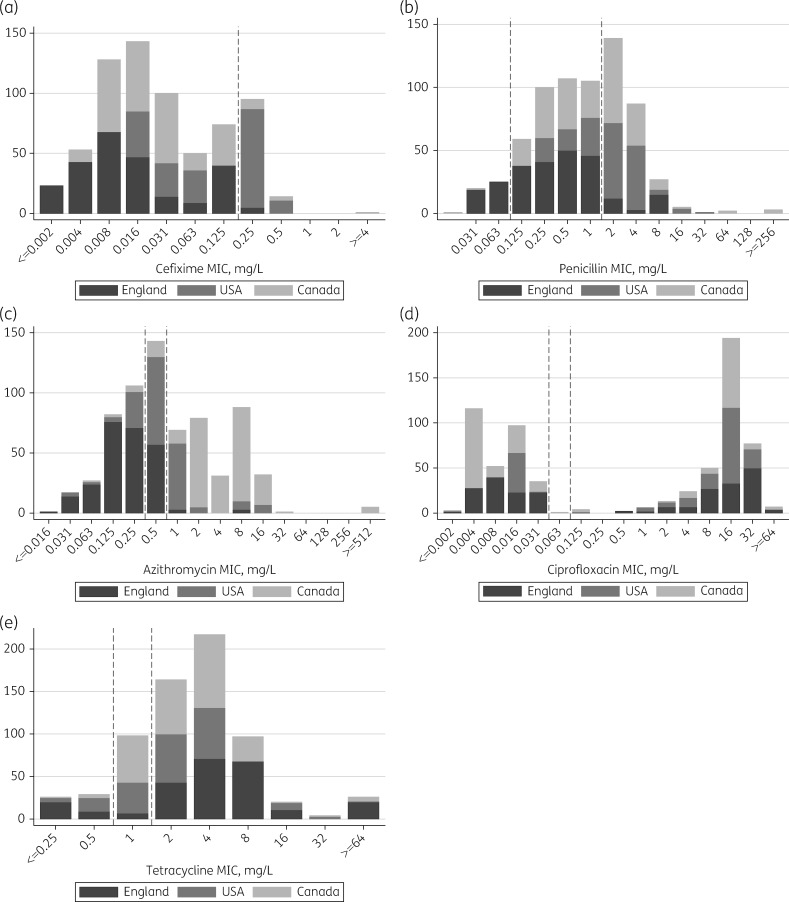
Distribution of measured MICs by country. EUCAST breakpoints for susceptibility and resistance (shown as dashed lines) are: azithromycin, ≤0.25 and >0.5; cefixime, ≤0.125 and >0.125; ciprofloxacin, ≤0.03 and >0.06; penicillin, ≤0.06 and >1; and tetracycline, ≤0.5 and >1 mg/L.20